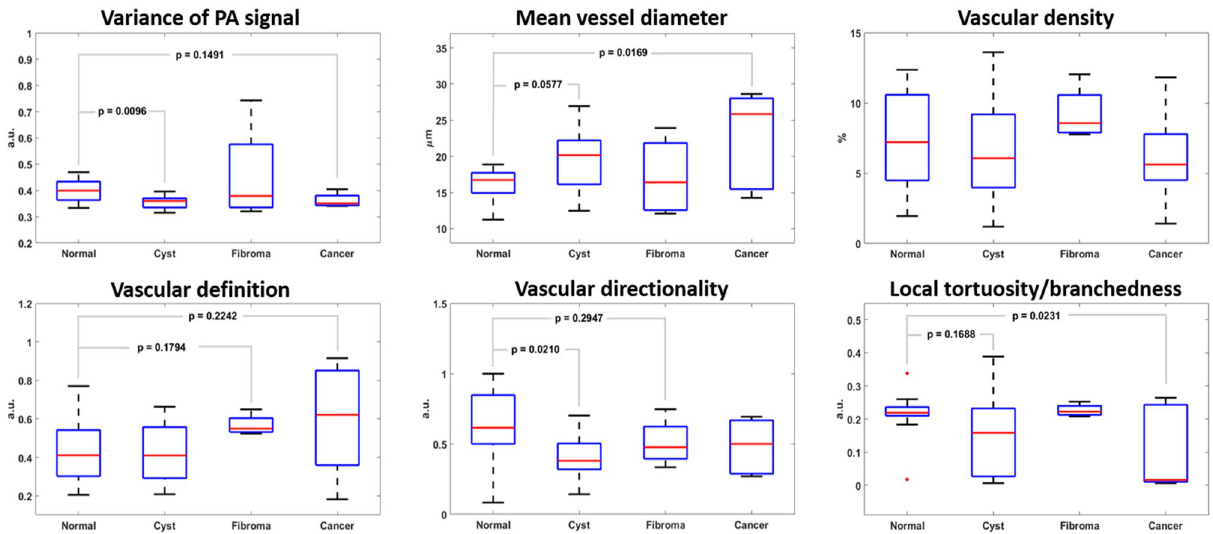
Figure 7. Comparison of morphological vascular feature differences between normal ovaries (n = 10) and ovarian lesions with various degrees of pathology (cyst, n = 13; fibroma, n = 4; malignant, n = 5).